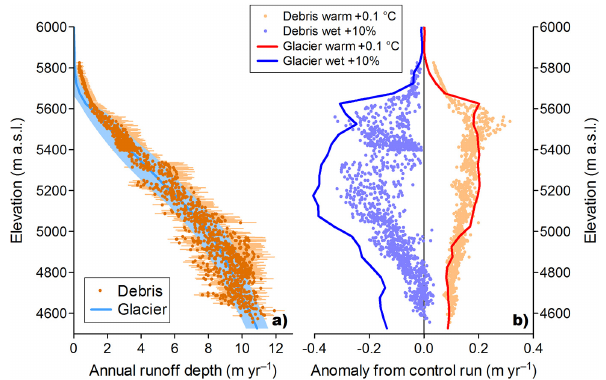
Figure 10. Elevation profiles of (a) annual runoff depth over debris- free glacier (Glacier) and debris-covered (Debris) surfaces, and of (b) responses under conditions of warming (air temperature in- crease 0.1 ◦ C) and wetting (precipitation increase 10%) of the Trambau Glacier calculated for the period 1979–2007 (28 years). Shading and error bars in (a) denote interannual variability for the same